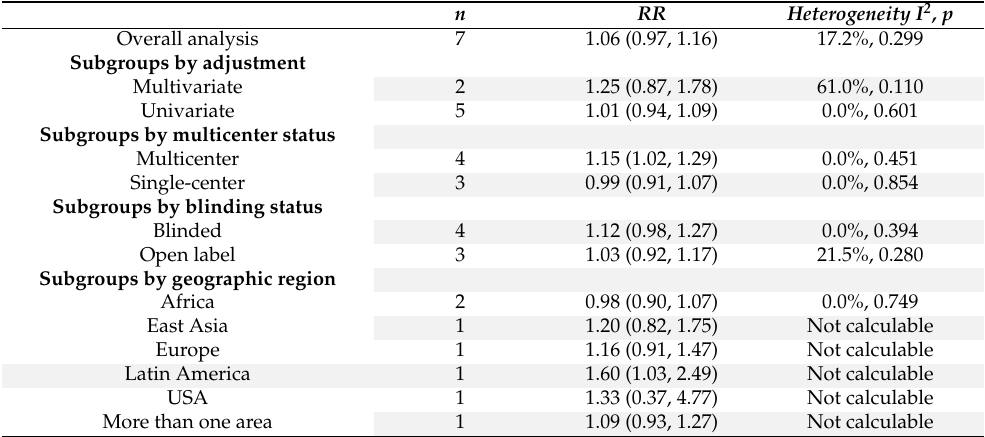
Table 5. Results of the meta-analyses examining the association between convalescent plasma therapy and score-related outcomes (28-day); subgroup analyses by adjustment, multicenter status, blinding status and geographic region are presented.